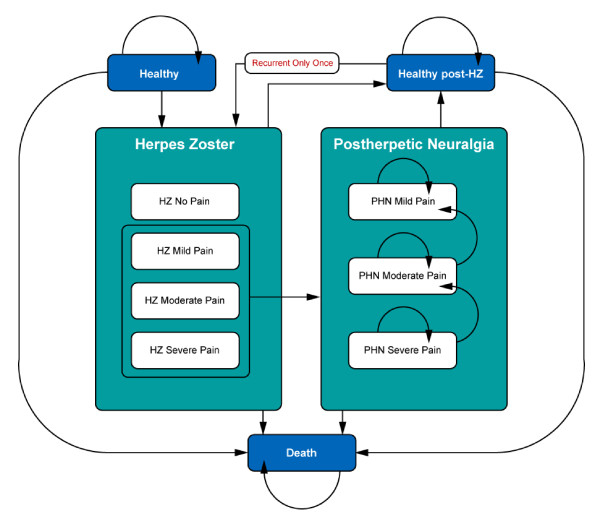
Model Health States.